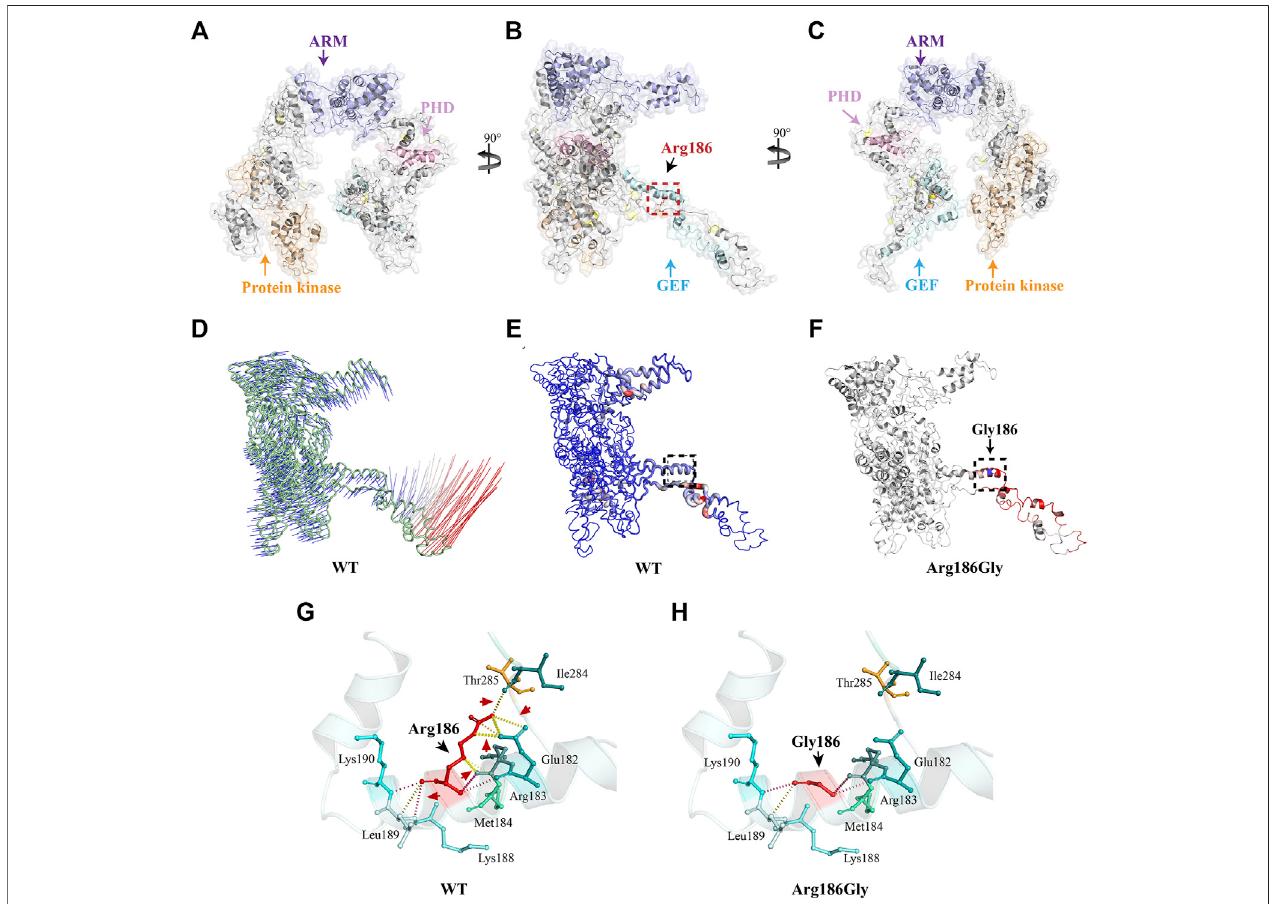
FIGURE 3 | Three-dimensional structure analysis and the protein dynamics of MAP3K1. (A) Three-dimensional structure as predicted by the I-TASSER online software. (B) As per (A) rotated 90 ° about the y -axis. The black dotted box marks the position of the Arg186 variant. (C) As per (B) rotated 90 ° about the y -axis. Yellow indicates the protein kinase domain, purple indicates the ARMadillo repeat (ARM) domain, pink indicates Plant Homeo Domain (PHD), and blue indicates the Guanine Exchange Factor (GEF) domain. The Arg186 amino acid residue of MAP3K1 is depicted as a red stick. (D) Vector fi eld representation of molecule for the fi rst non- trivial mode of molecular motion based on Normal Mode Analysis. The short (blue) and long (red) curves represent the change of trajectory. (E) Deformation energy of wild-typeMAP3K1:Themagnitudeofthedeformation/ fl uctuationisrepresentedbythintothicktubescoloredblue(low),white(moderate),orred(high).Theblackdotted box marks represent the position of Arg186. (F) Δ Vibrational Entropy Energy | Visual representation of variant: Amino acids colored based on the vibrational entropy changeofthevariant. Bluerepresentsarigidi fi cationofstructure.Redrepresentsagainin fl exibility. (G,H) Interaction predictionbetweenaminoacidresidues: Wild-type and variant residues are represented as red sticks. These are placed alongside surrounding residues which are also involved in other types of interactions. Red arrows indicate interactions between altered amino acids. Black arrows indicate wild-type or variant amino acid residues. Hydrogen bonding is shown with a yellow dotted line.